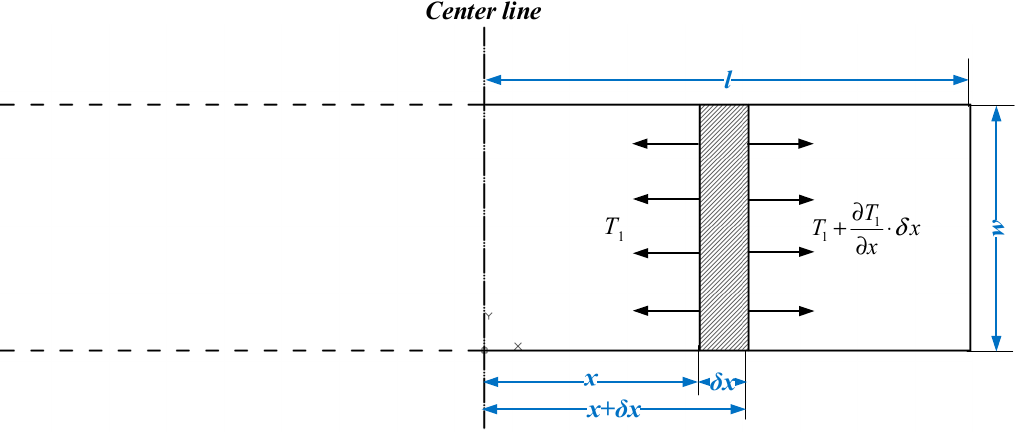
Figure 2. Infinitesimal element of piezoelectric ceramics (PZT).